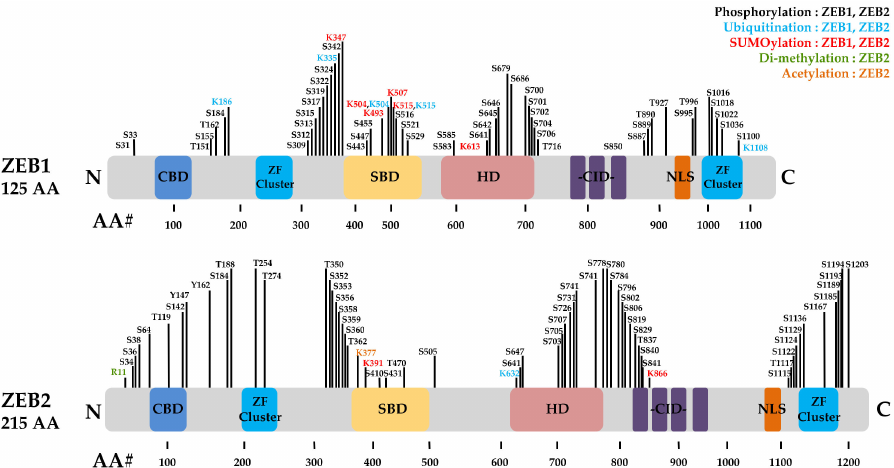
Figure 1. Overviews of ZEB1 and ZEB2 PTMs. It is characterized by the presence of two zinc finger clusters, one at each end (NZF and CZF) and located homeodomain (HD). Other domains are P300-P/CAF interaction domain (CBD), the Smad binding domain (SBD) and the CtBP interaction domain (CID). ZF, zinc finger; NLS, nuclear localization signal. PTM site. Black, Phosphorylation (ZEB1, ZEB2); Sky blue, Ubiquitination (ZEB1, ZEB2); Red, SUMOylation (ZEB1, ZEB2); Green, Di-methylation (ZEB1, ZEB2); Orange, Acetylation